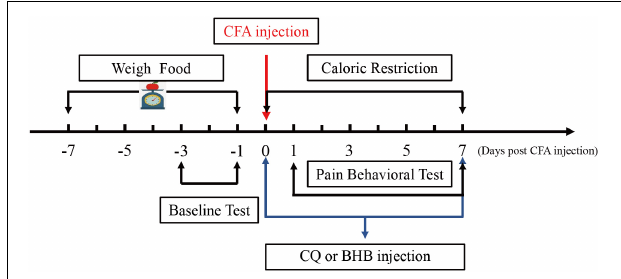
FIGURE 1 | Schematic diagram showing the time points of CR administration and the CQ, BHB